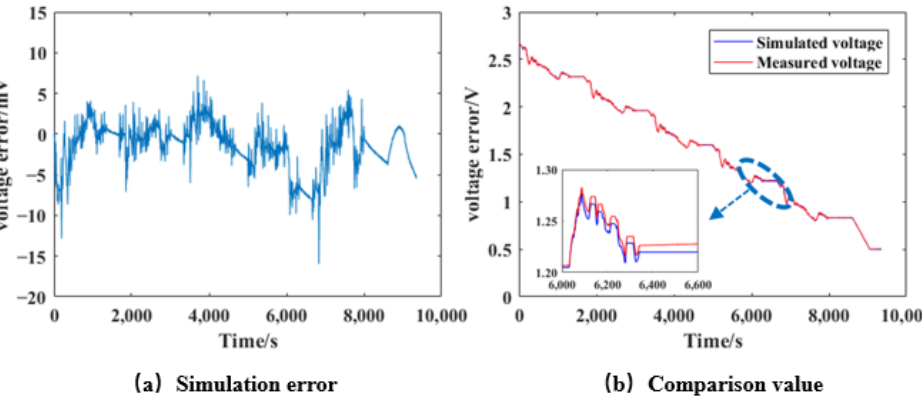
Figure 3. UDDS-based Thevenin model validation diagram. ( a ) Simulation error variation figure ( b ) Comparison of simulation terminal voltage and measured value After parameter identification based on the data obtained from the HPPC, the maxi- mum error, mean error, and root mean square error (RMSE) of the eight models were ,respectively, calculated under the UDDS, as shown in Table 3. Table 3. Errors of the eight models.